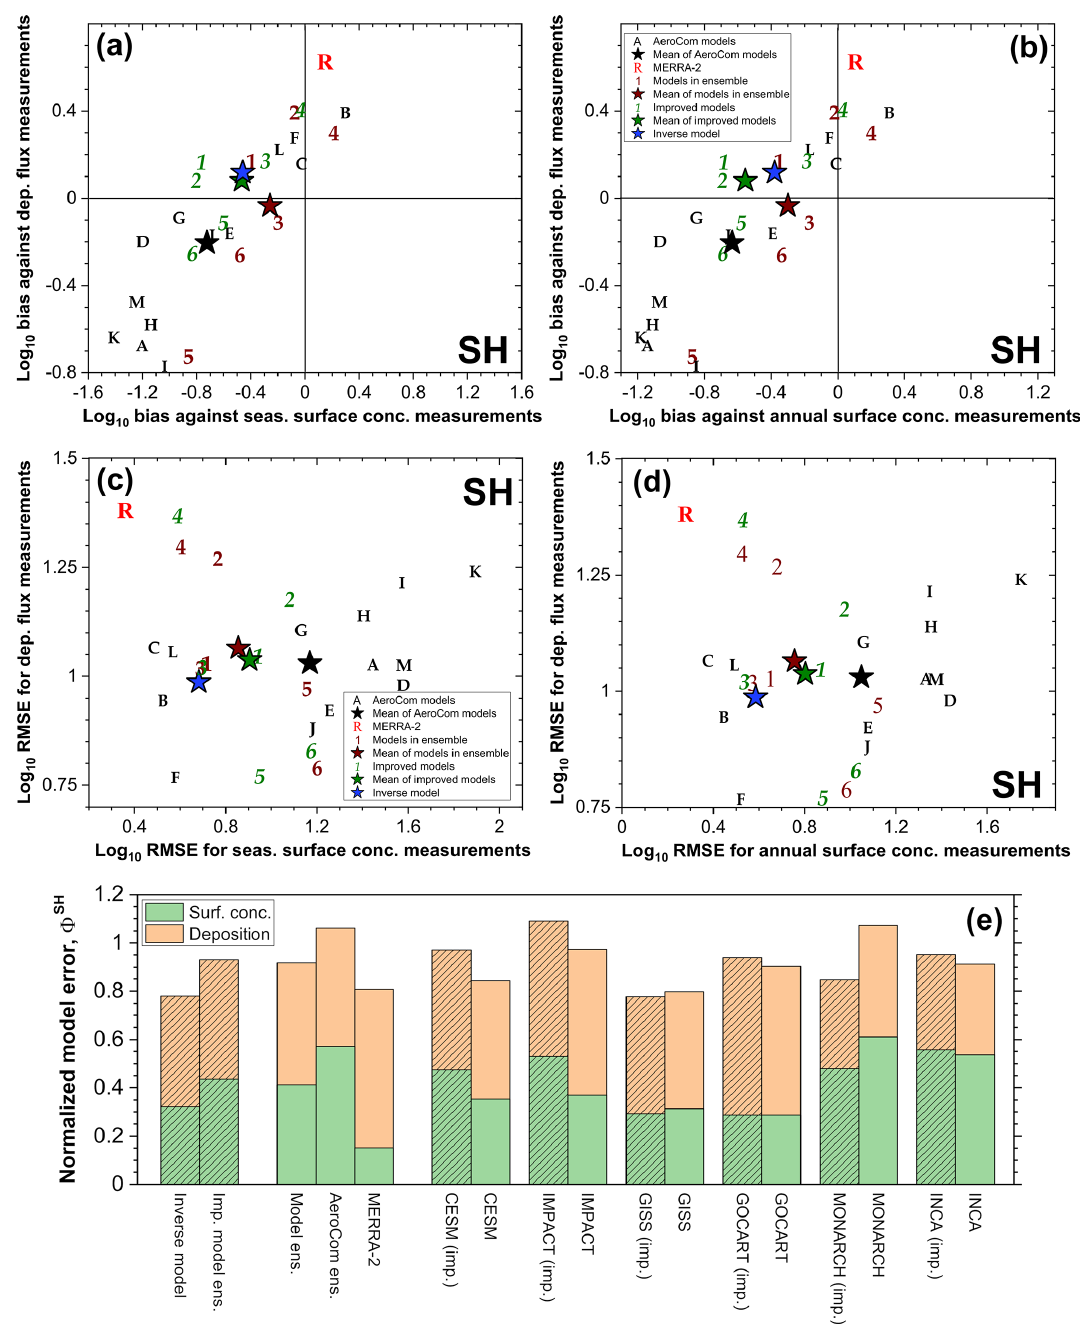
Figure 11. Evaluation of whether integrating observational constraints on dust properties and abundance produces an improved representation of the Southern Hemisphere dust cycle. Shown are the biases (a, b) and root mean square errors (RMSEs; c, d ) in logarithmic space with respect to measurements of (a, c) seasonally averaged dust surface concentration and dust deposition flux and of (b, d) annually averaged dust surface concentration and deposition flux. Symbols in panels (a) – (d) denote results for the individual models in the AeroCom ensemble (black letters), MERRA-2 (red R ), models in our ensemble (brown numbers), and the improved models (green italicized numbers). The exact legend for the different models is given in Fig. 3, and stars denote the mean bias and RMSE for AeroCom models (black star), models in our ensemble (brown star), the improved models (green star), and the inverse model results (blue star). Panel (e) shows normalized model errors (see Sect. 3.2) relative to the surface concentration (green bars) and deposition flux (orange bars) datasets. Shown are results for the inverse model; the average of models in the AeroCom ensemble, our model ensemble, and our ensemble of improved models; MERRA-2; and for the individual models in our ensemble before and after applying observational constraints (see Sect. 2.5). Hatched bars denote results of the inverse model and improved models obtained through our